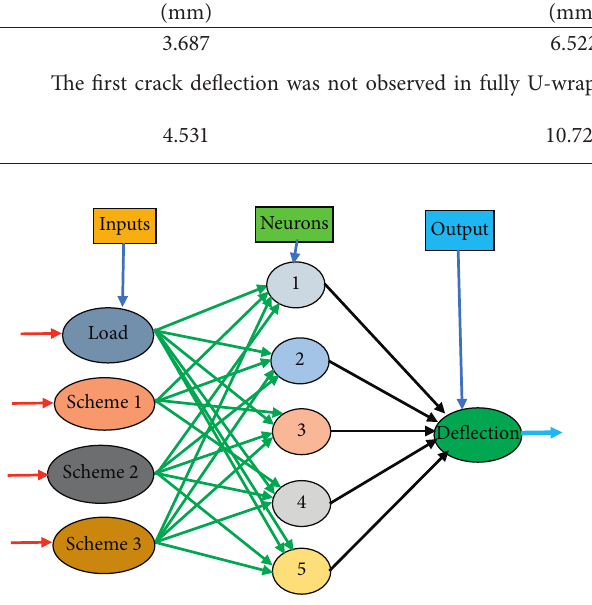
Figure 8: General ANN structure.